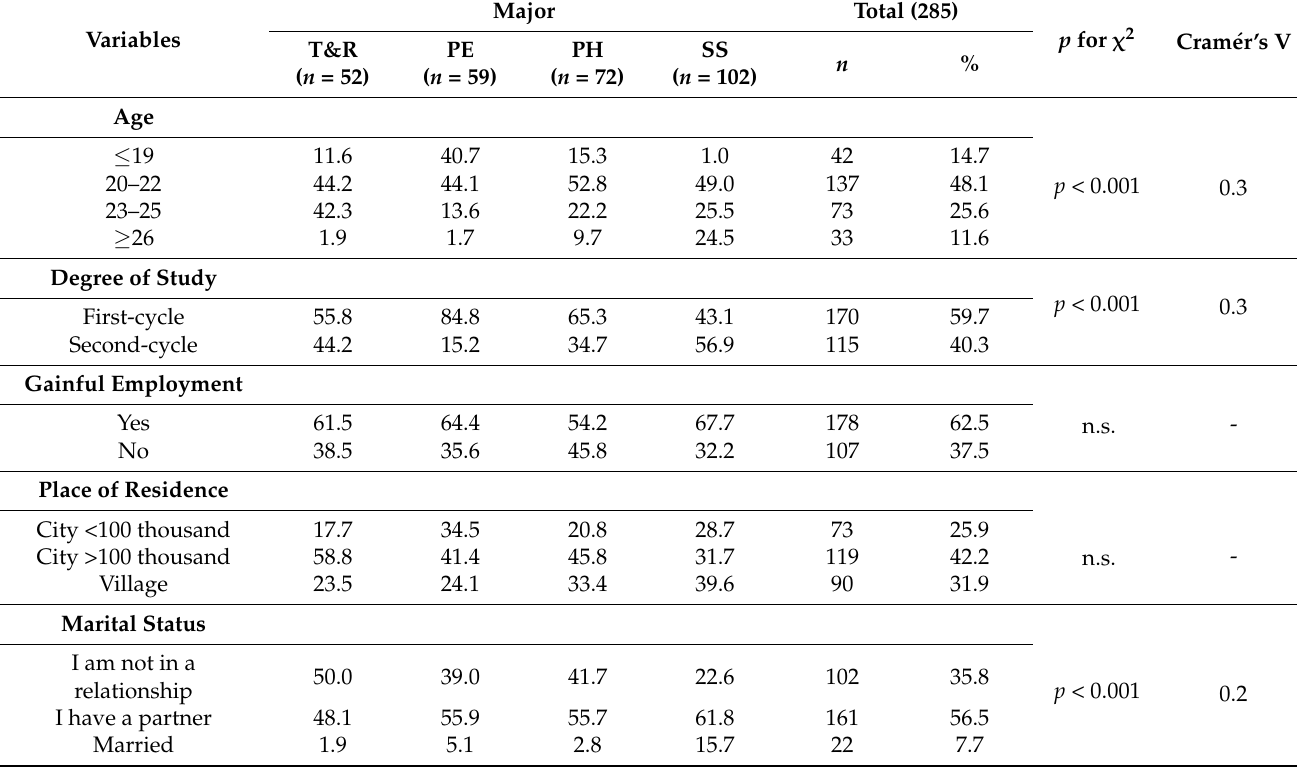
Table 1. Socio-demographic characteristics of students (independence χ 2 test and Cram é r (cid:48) s